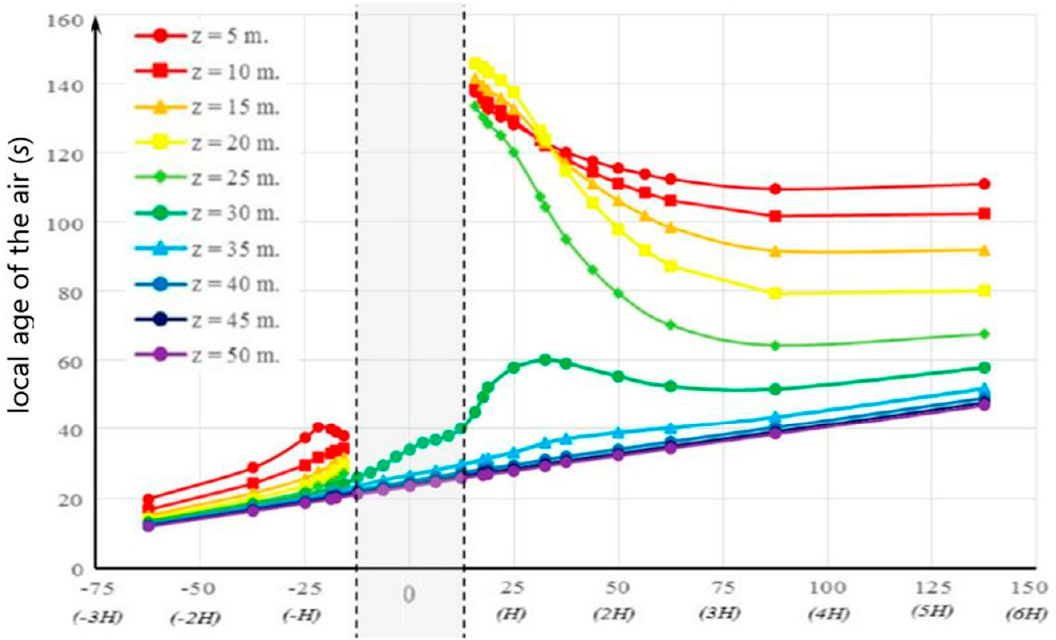
Figure 7. Local mean age of the air (LMAA) vertical histogram distribution. Longitudinal centered section.